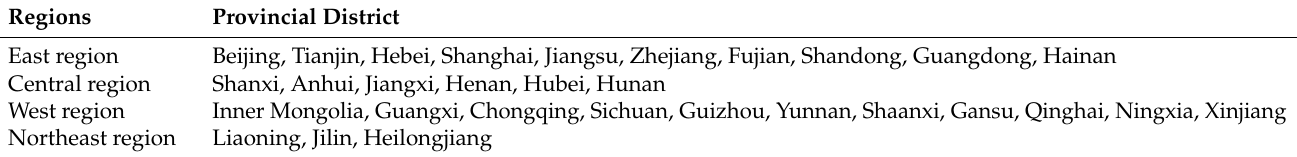
Table 1. Four regions and their provincial